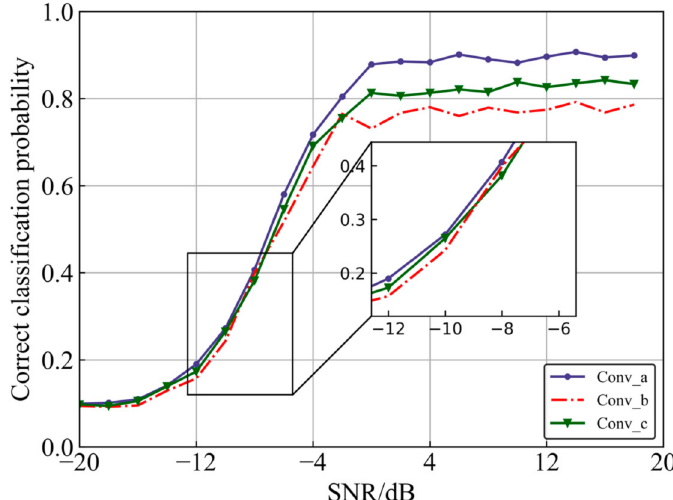
Figure 4. Three convolution methods.